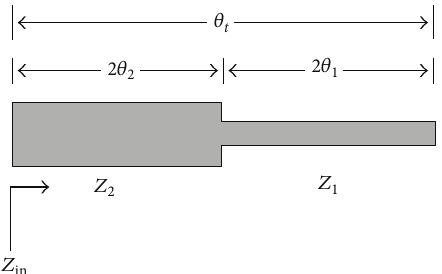
Figure 12: Structure of the asymmetric two-section SIR used in